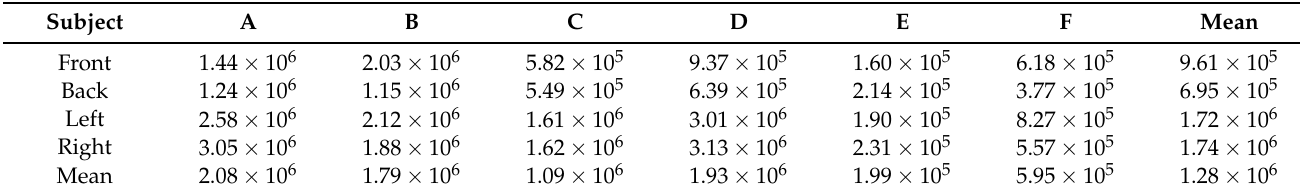
Table 3. Parameter λ used in the movement duration optimization model for each subject.